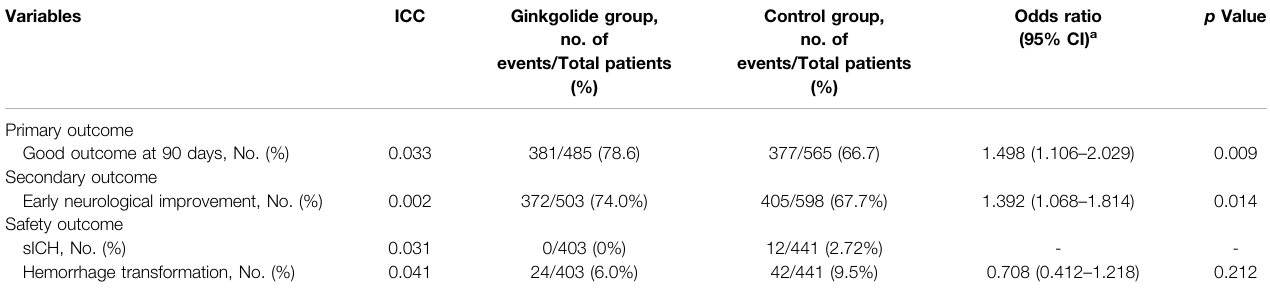
TABLE 2 | Neurological Outcome and Complication Among Ginkgolide intervention vs. Control Group after binary logistic regression. Variables